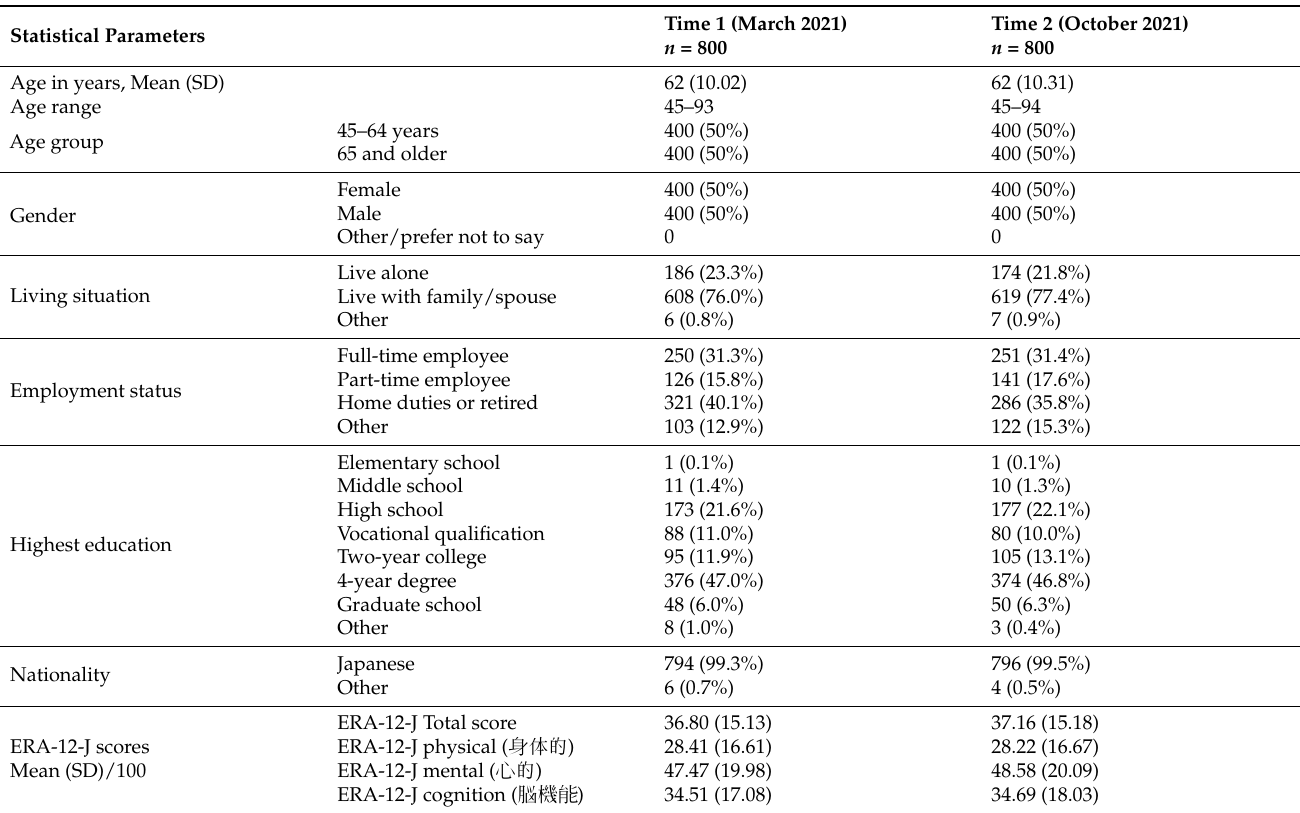
Table 1. Demographic characteristics (N = 1600) and ERA-12-J scores.